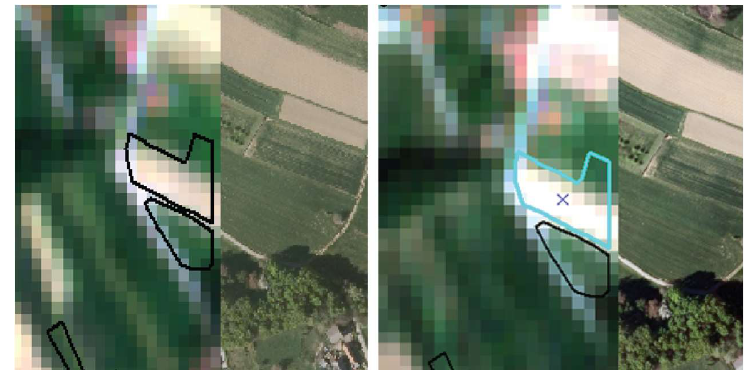
Figure 10. S-2 images ( left : 2016 growing season, right : 2017 growing season) provided additional information to confirm problematic dates of changes for a particular object (object no. 2). Digital orthophoto in the background with 1 m spatial resolution, but single date land use state information (April 2016).